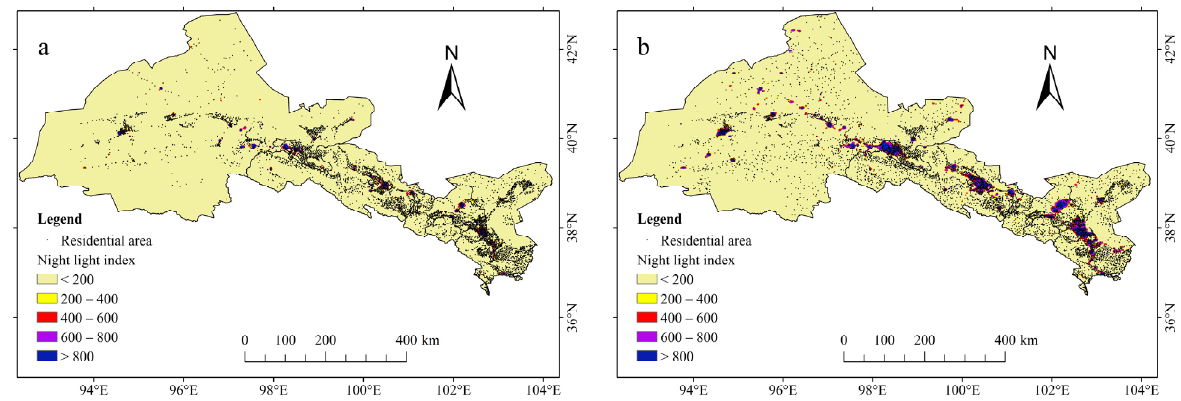
Figure 7. Night light index and residential areas of the Hexi Corridor in ( a ) 2000 and ( b ) 2020. Further analysis of the spatial distribution of NDVI change associated with the dif- ferent vegetation types indicated that vegetation (or crop) growth increased in grassland